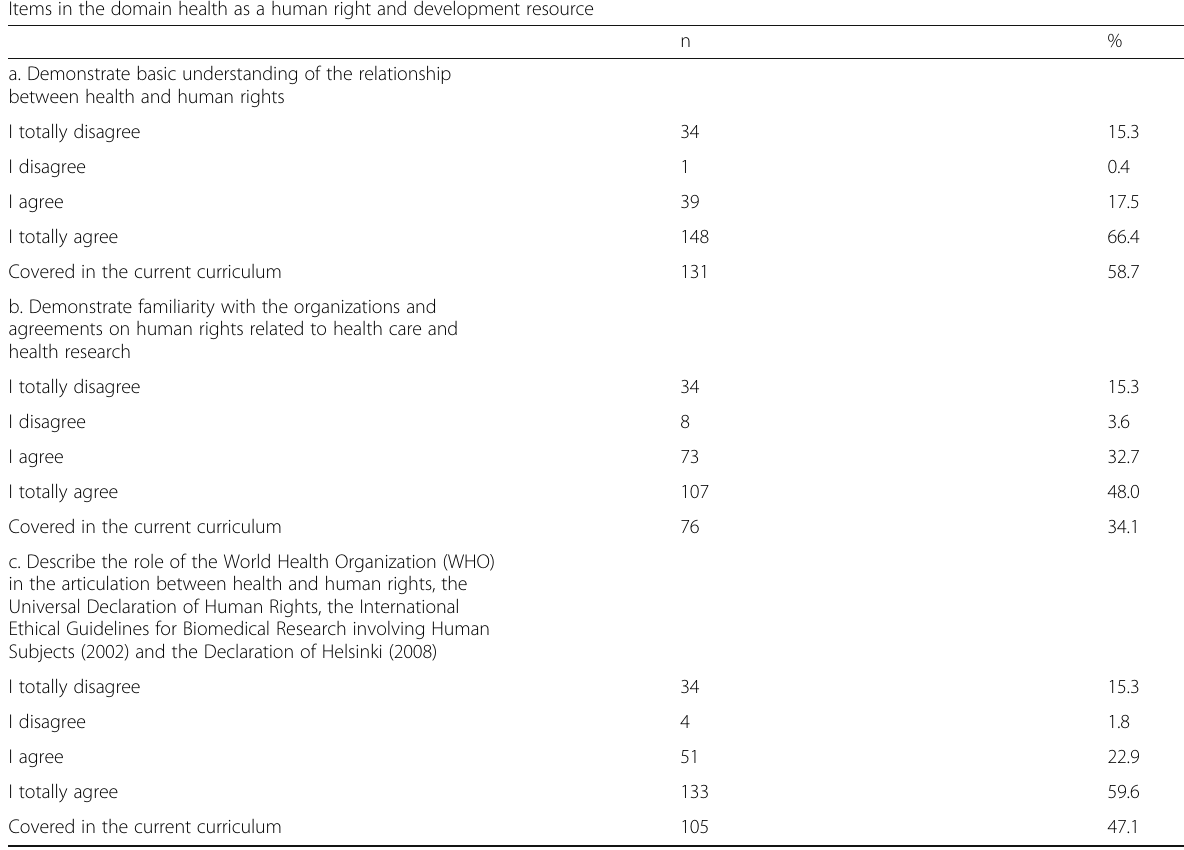
Table 1 Description of participants ’ answers to the items in the domain Health as a Human Right and Development Resources, which are covered in the current curriculum Items in the domain health as a human right and development